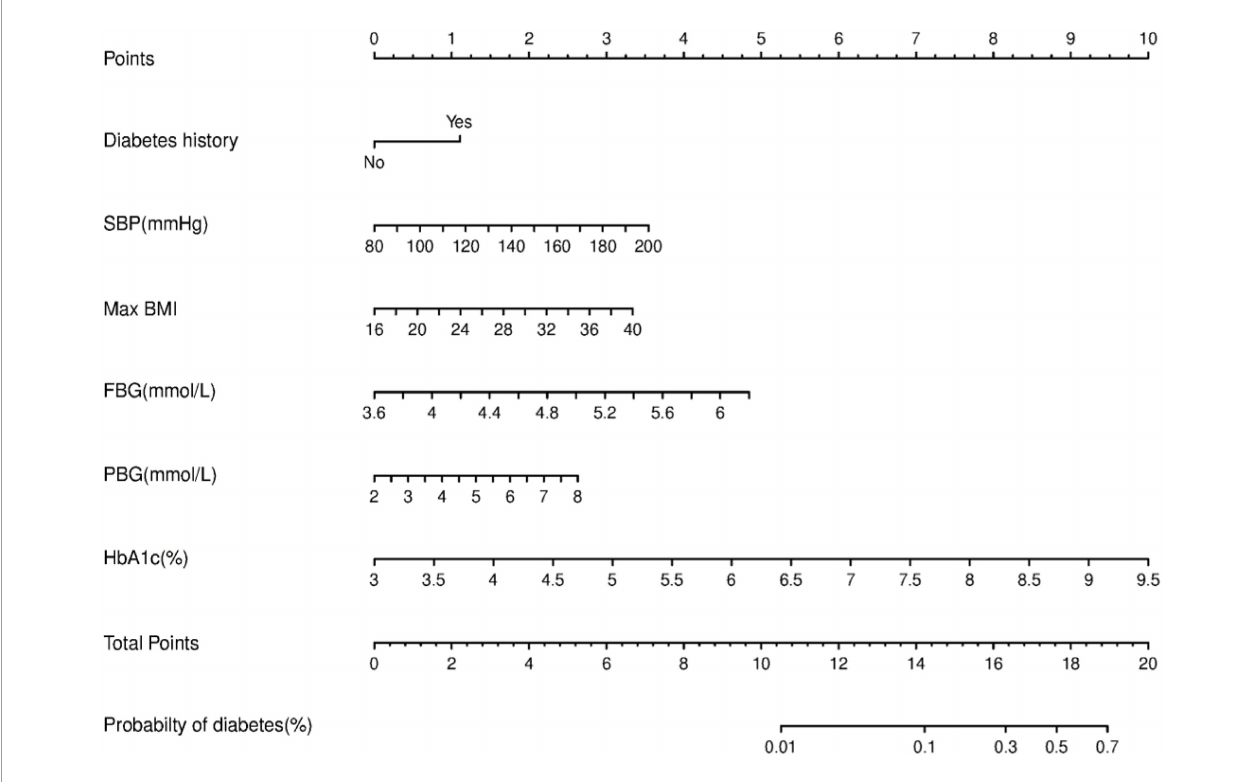
FIGURE 1 | Nomogram predictive model for